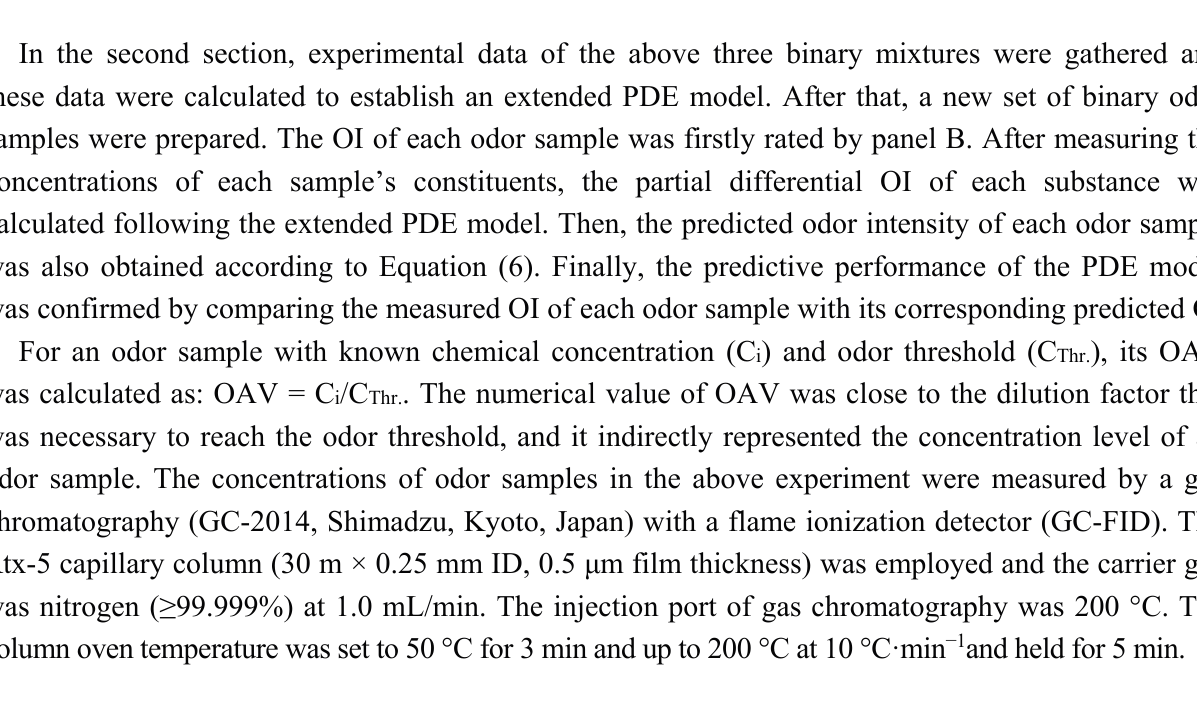
Figure 2. Experimental scheme of the two sections for ( 1 ) the establishment of PDE model and ( 2 ) the confirmation of its odor intensity predictive